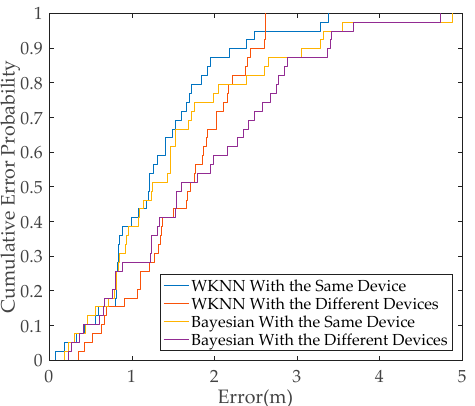
Figure 3. Comparison of the positioning performance of conventional methods in the same and different smartphones.